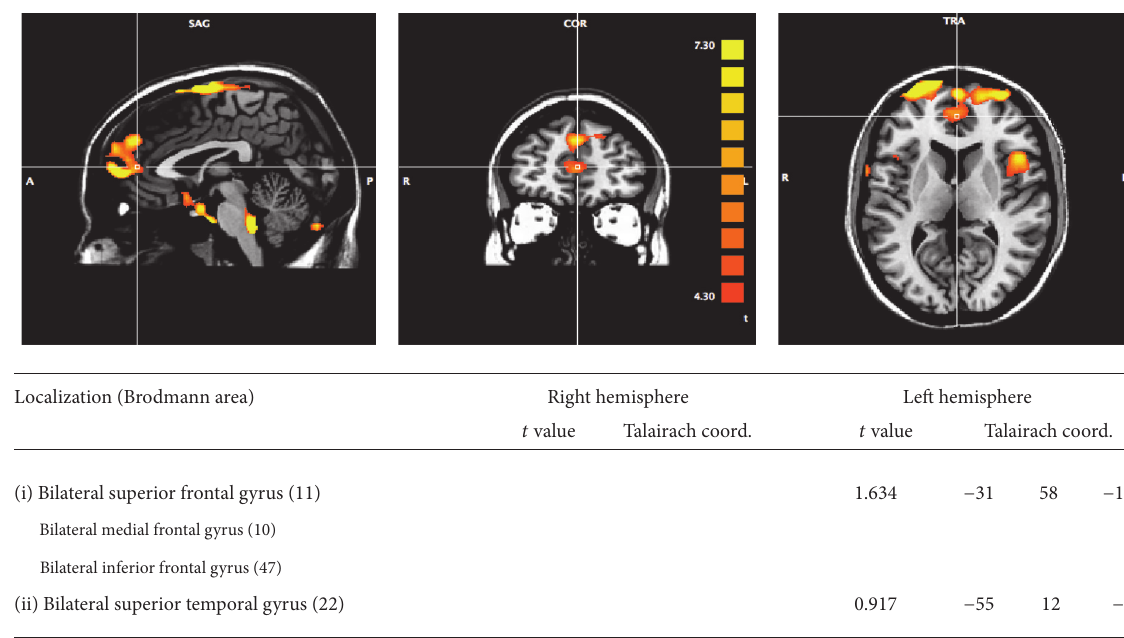
Figure 2: Patient R.M., post- minus pretreatment changes computed as the ALFF index. Talairach coordinates of local maxima of structures showing significant activity ( 𝑝 < 0.05 , corrected for multiple comparisons). The amount of increase in the ALFF between sessions for the two clusters was 45% and 29%,